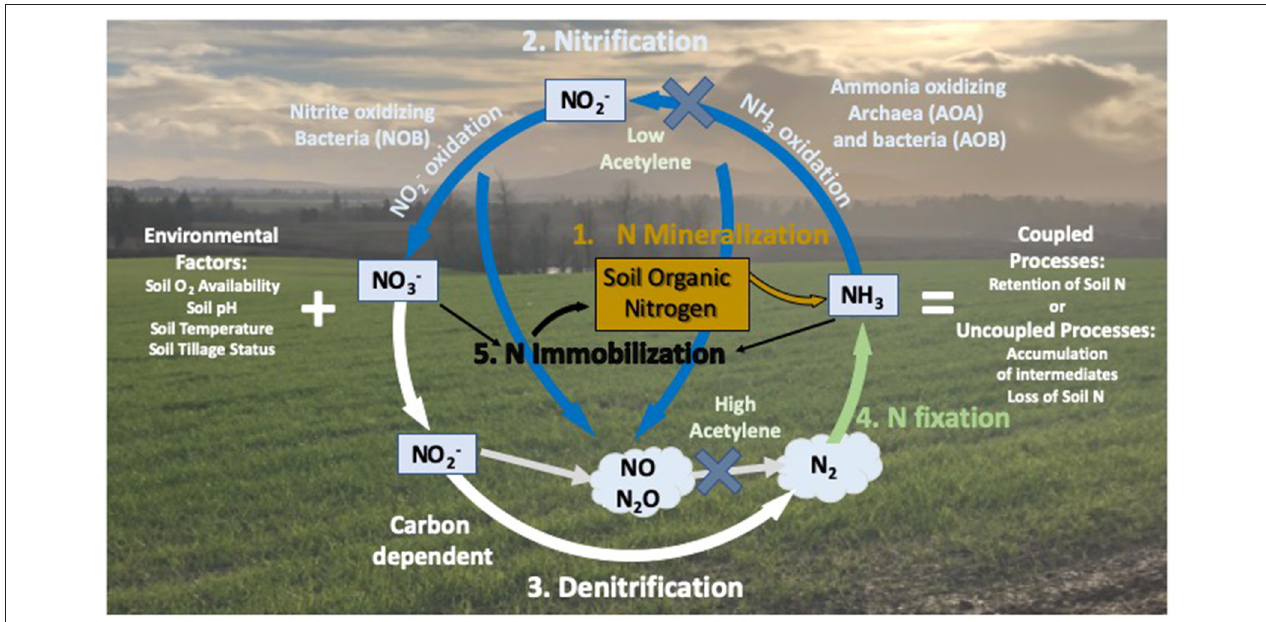
FIGURE 1 | Nitrogen cycling in terrestrial systems. N cycling in terrestrial systems is microbially mediated with heterotrophic microorganisms mineralizing soil organic nitrogen (Step 1) to ammonium/ammonia (NH + 4 /NH 3 ), oxidation of NH 3 to nitrite (NO − 2 ) then nitrate (NO − 3 , Step 2) by nitrifying microorganisms, and denitrification to N oxide gases and dinitrogen gas (Step 3). Inorganic N is recovered through N fixation of dinitrogen through microbial action and natural events (lightning as an example) to form NH 3 (Step 4), and inorganic N returns to the soil organic nitrogen pool through N immobilization by microorganisms (Step 5). Microbial N cycling in soils is a key regulator of N availability to plants and other players in terrestrial system. The addition of acetylene at varying levels affects different steps in the N